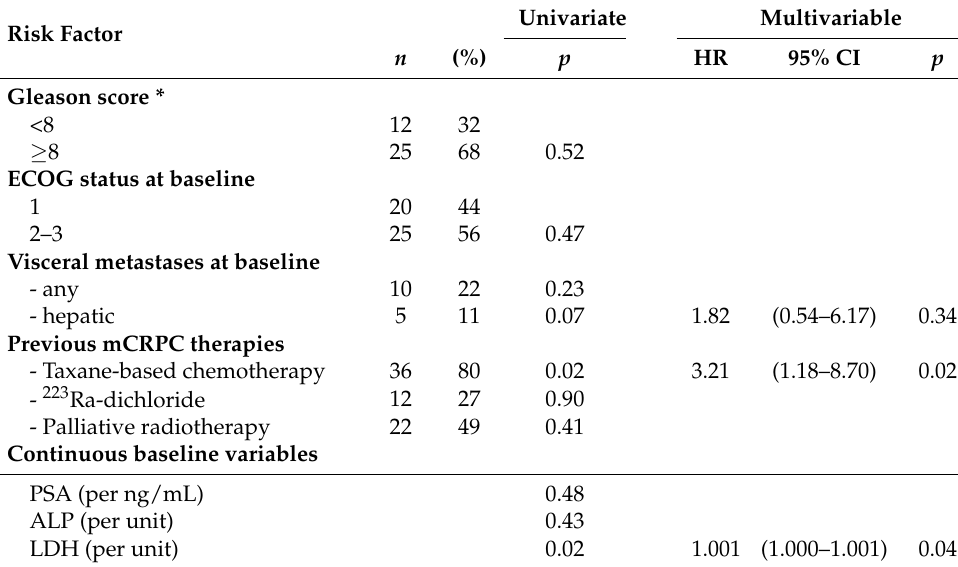
Table 2. Univariate and multivariable